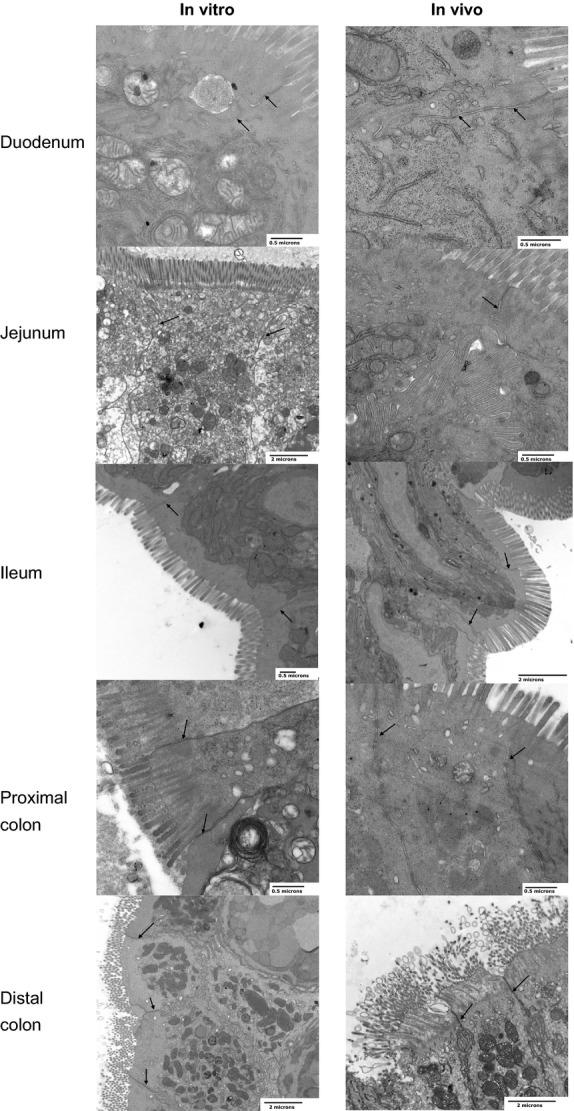
Electron Microscope images of different regions of the small and large intestine processed following in vitro or in vivo measurement of phosphate uptake. Tight junctions are indicated by arrows (scales bars = 0.5 or 2 microns).